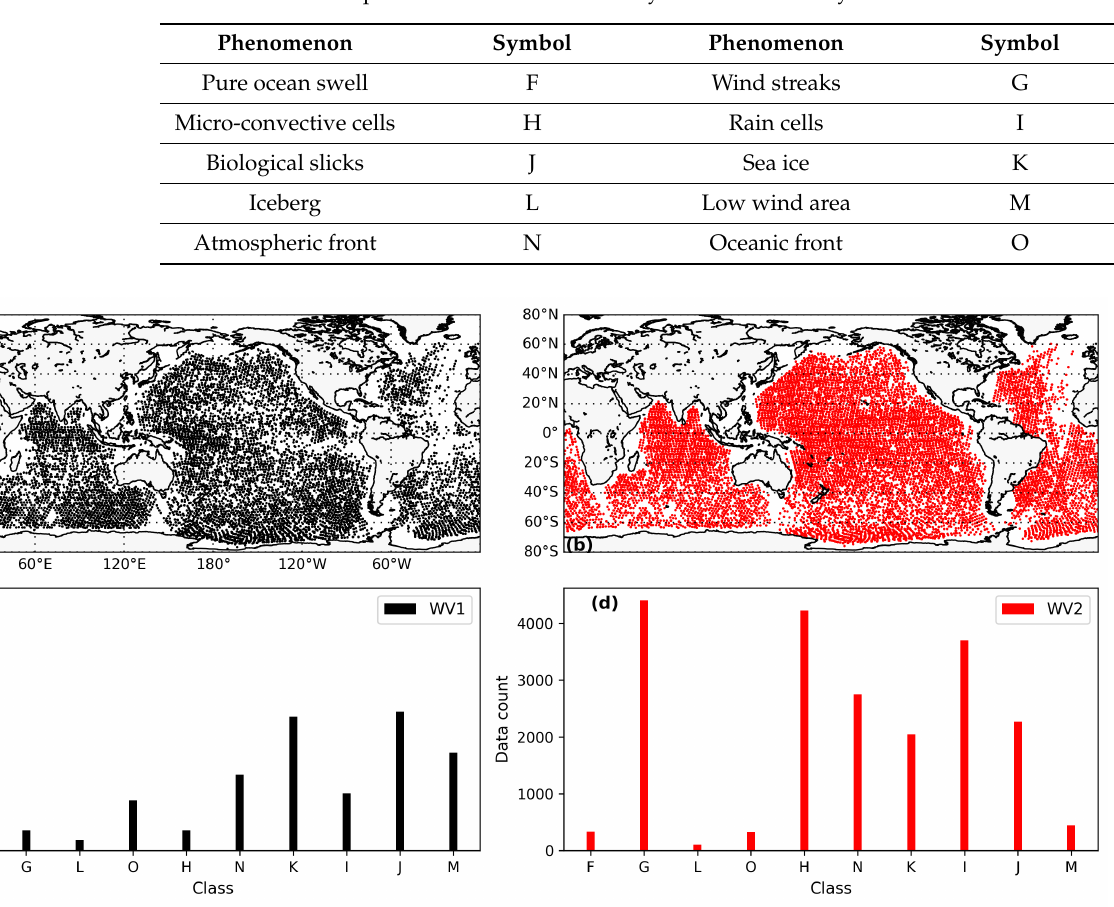
Table 1. Ten labeled phenomena and their short symbols in this study.